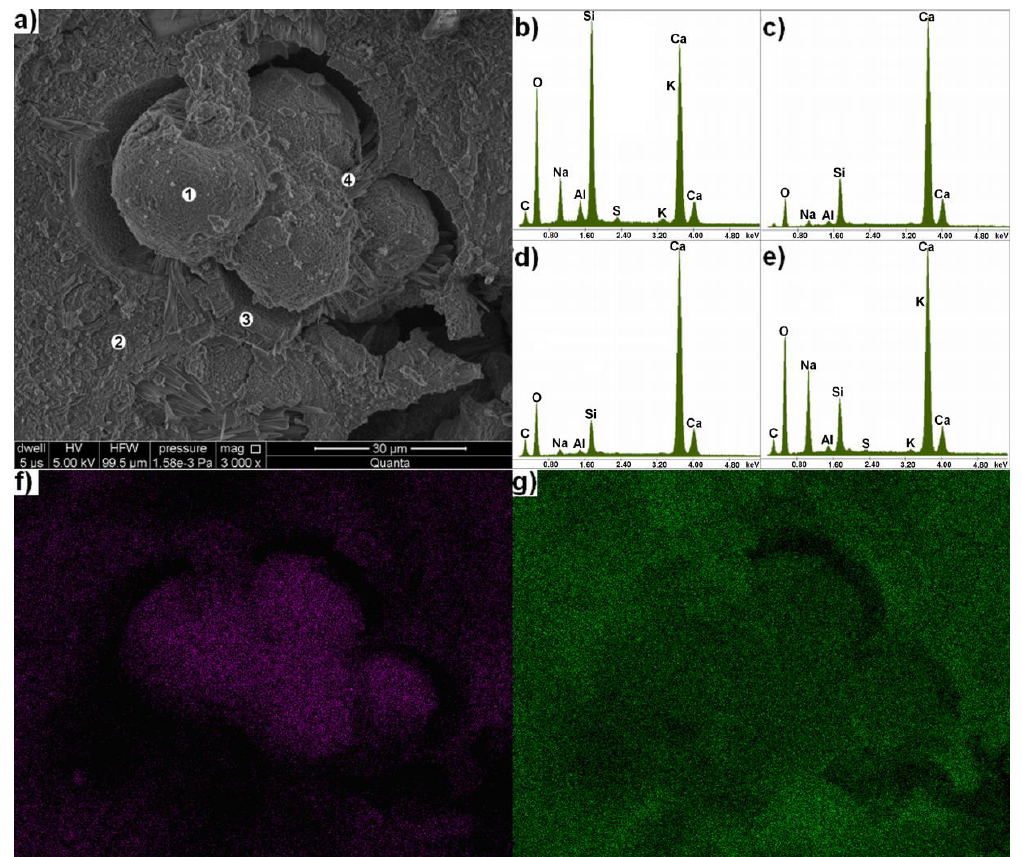
Figure 8. ( a ) a cracked grain of carbonate aggregate in mortar at 3000× magnification and X-ray microanalysis of elemental composition in point; ( b ) 1; ( c ) 2; ( d ) 3; ( e ) 4, and distribution maps of ( f ) Si; and ( g ) Ca.